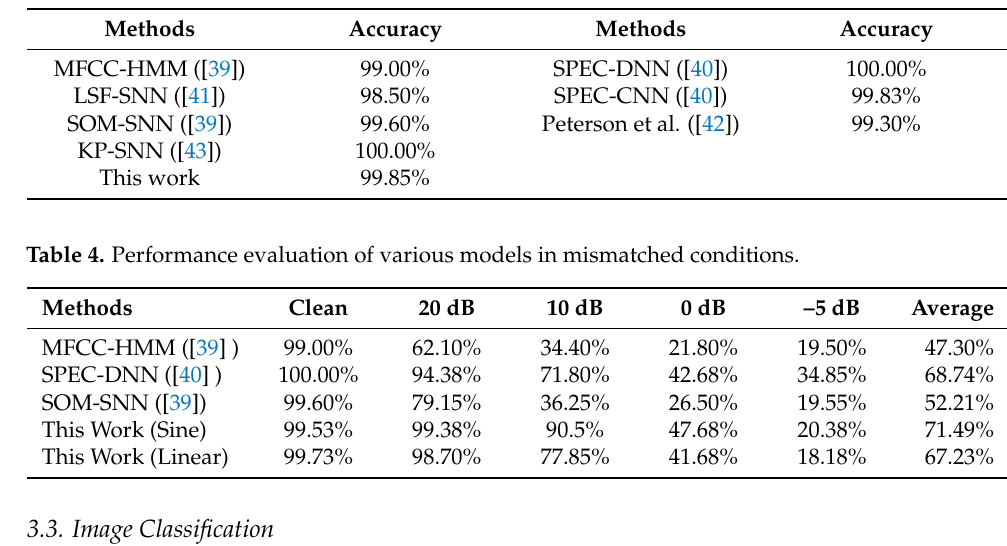
Table 3. Comparison of performance with different models.